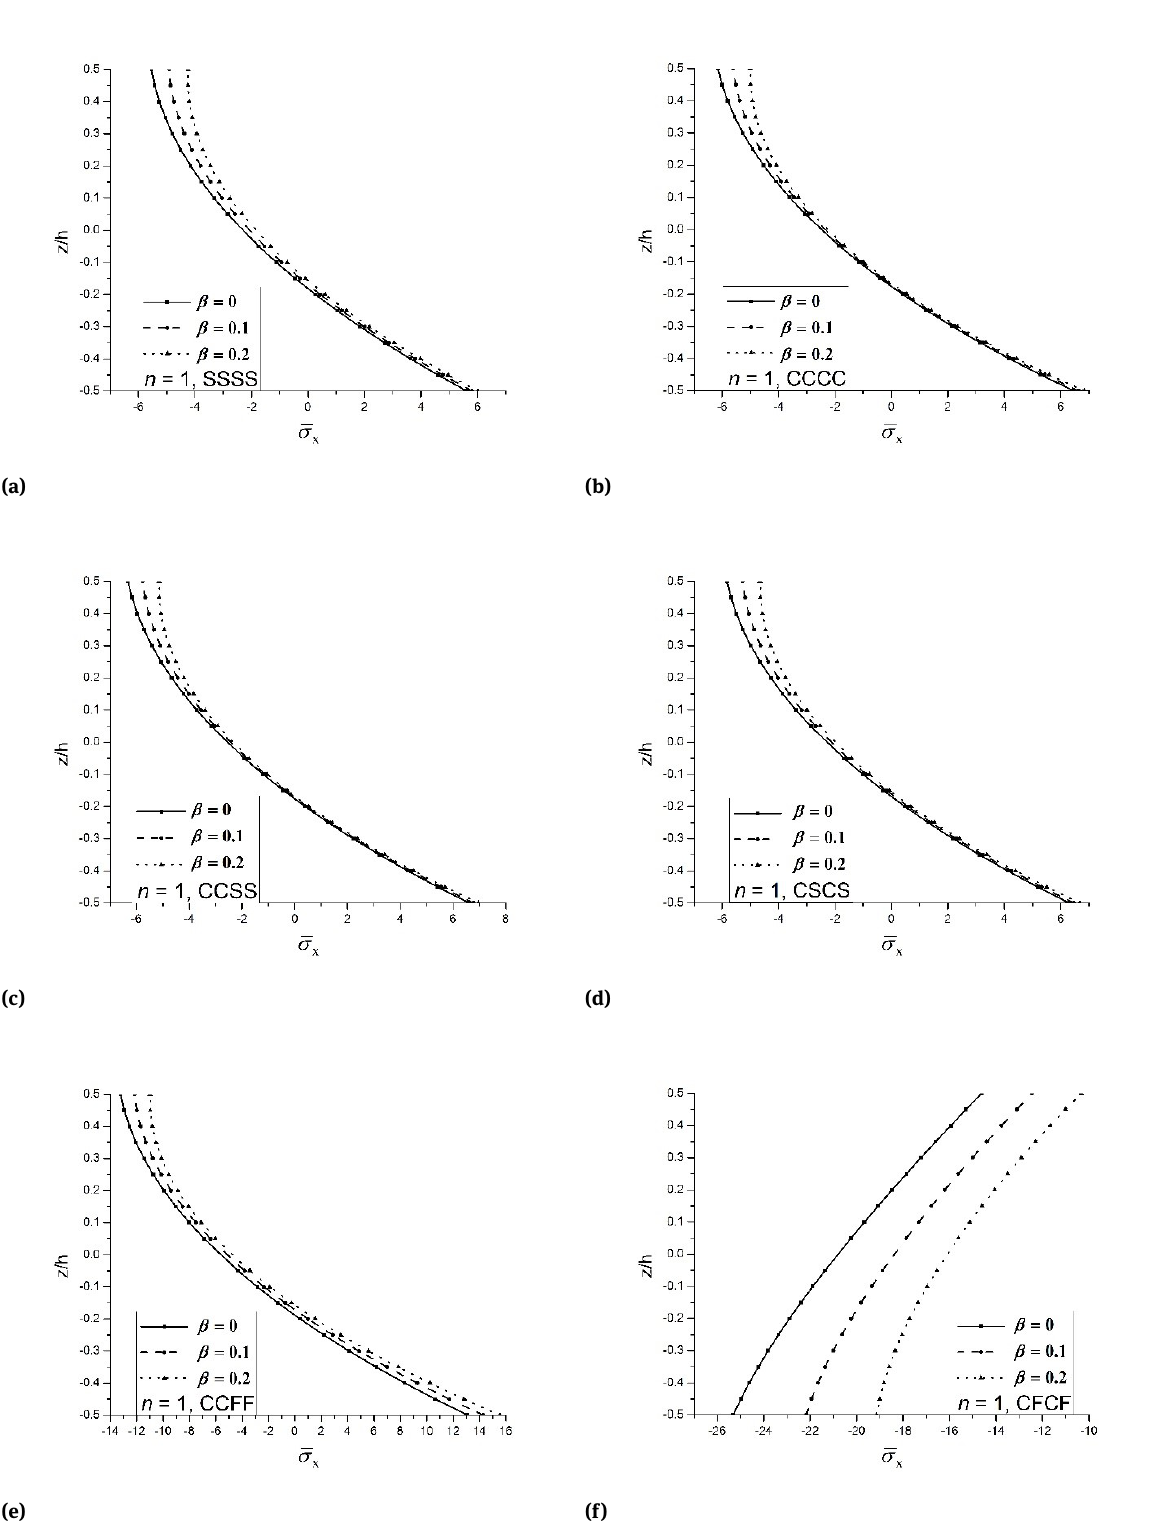
Figure 6: Effect of porosity on dimensionless axial stress of FGM-1 porous conoidal shell under uniform